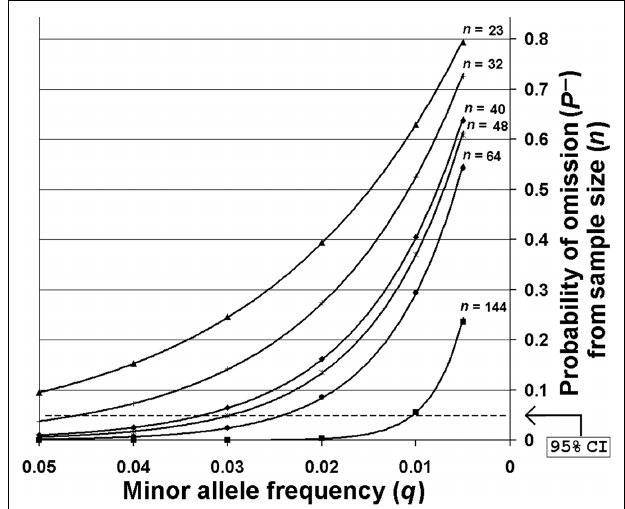
FIGURE 2 |The probabilities of not sampling SNPs with minor allele frequencies ≤ 0.05. Sampling probabilities were calculated for minor allele frequencies across biological sample sizes ( n ) that were used for empirical Ostrinia nubilalis data collection.The predicted sample size required to obtain accurate minor allele frequencies with 95% probability [ ∼ 95% confidence interval (CI)] is shown for Cus d’leon and Huegas, France ( (cid:2) ), ◦ Landisville, PA ( ), all French subpopulations ( (cid:3) ), Kanawha, IA ( (cid:4) ), • Rockspring, PA ( ), and all North American subpopulations ( (cid:5) ).The probability of not sampling a rare allele from a population that was genotyped ( P − ) was calculated using P − = (1 − q ) 2 n as described by Swofford and Berlocher